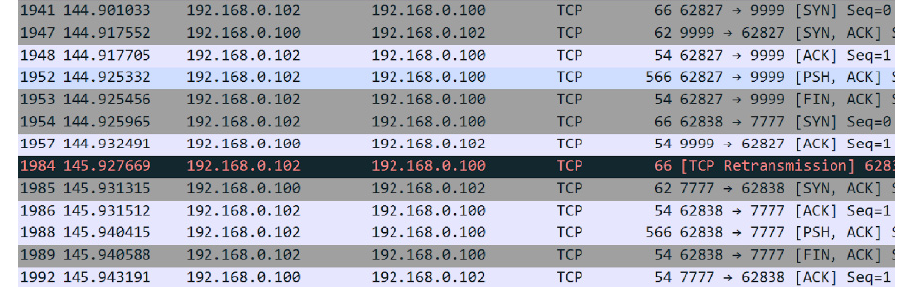
Figure 19. Initial block creation process transfer of block and signature from 192.168.0.102 to 192.168.0.100.